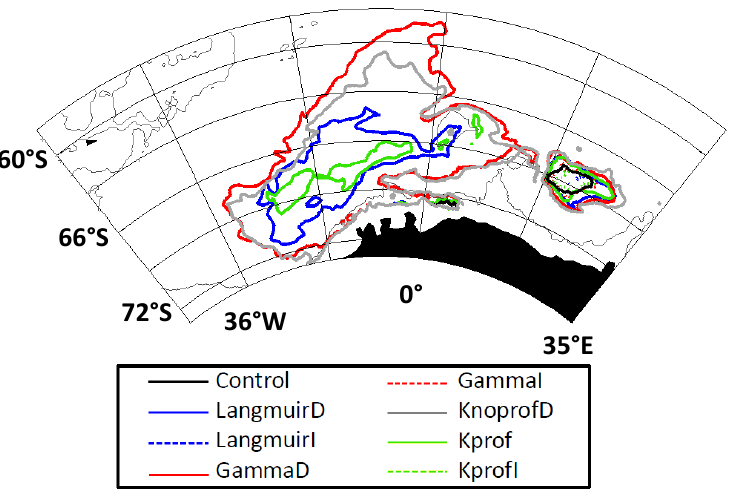
Figure 5. For each experiment, contours indicating where the maximum 1980–1989 MLD exceeds 2000m in the Weddell Gyre region (magenta box in Fig. 1). Thin grey contours indicate the 3000m isobath. Note that the contours for the increased-parameter experiments and the control mostly coincide.